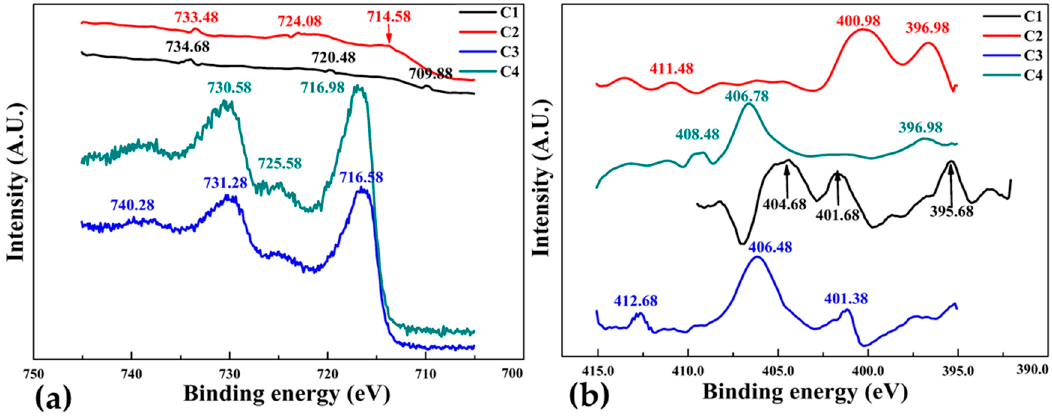
Figure 12. X-ray photoelectron spectra of group 3, FeN thin films deposited at different deposition time spans. ( a ) Fe 2 P and ( b ) N1s.